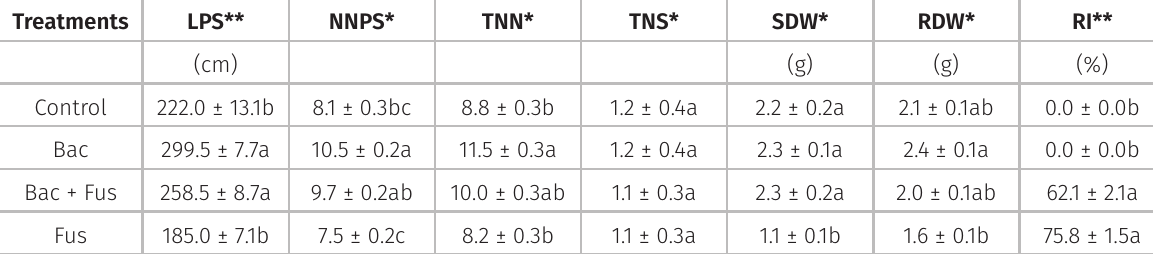
* Equal letters indicate no statistically significant difference according to ANOVA followed by Tukey test ( p ≤ 0.05). ** Equal letters indicate no statistically significant difference according to Kruskal-Wallis followed by Dunn-Bonferroni test ( p ≤ 0.05), for non-parametric